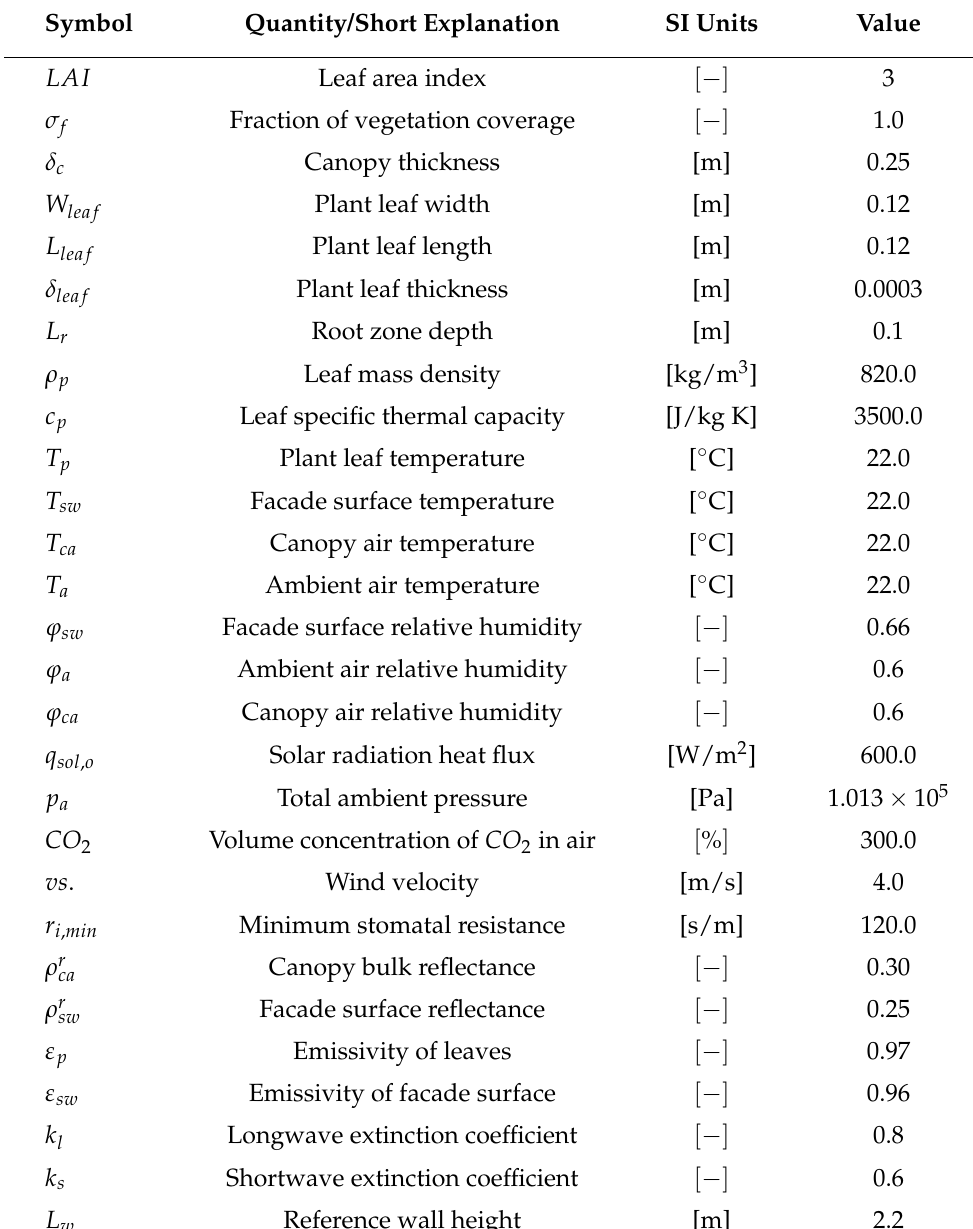
Table 1. Required input data defining the reference greenery system/canopy